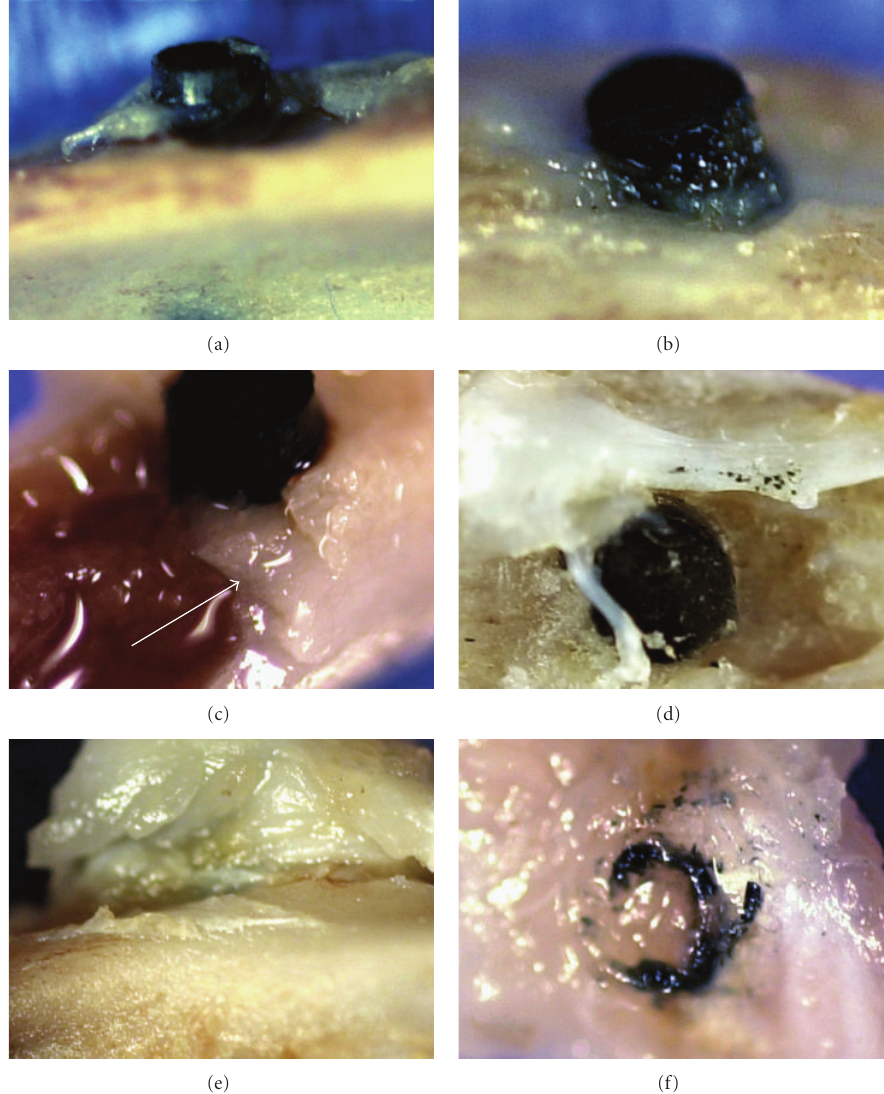
Figure 2: Photograph imaging of 1.5 mm diameter bisphenyl-polymer/carbon-fiber implants and tissue: (a, b) upper cortical bone plate with osteoid growing up the composite implant surface. (c) Fracture of the bone after fixation. (d) Separate tests not included in the statistical analysis incorporated minor insignificant bisphenyl-polymer/carbon-fiber fragments as particulate cuttings retained along the implant before surgery which resulted in an overly exuberant collagenous osteoid response extruded on the lower cortical plate over the implant end. (e) Dissection exposes an extremely tough fibrous cu ff surrounding the entire implant circumference. (f) Tissue dissection of the fibrous cu ff provides evidence of carbon fine particulate and fiber